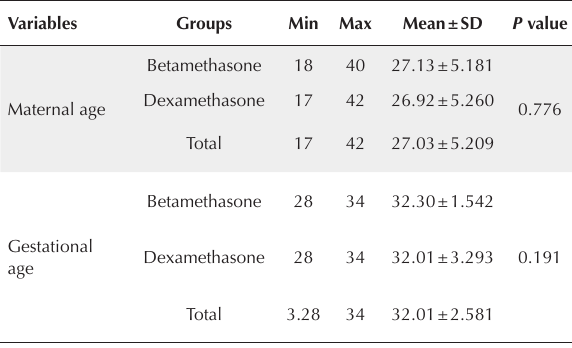
Table 1. Comparison of Maternal and Gestational Ages in the Two Groups Receiving Dexamethasone and Betamethasone Variables Groups Min